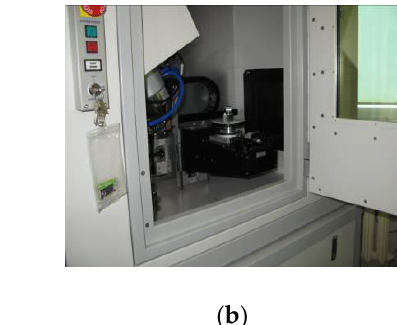
Table 2. Selected polymer materials.